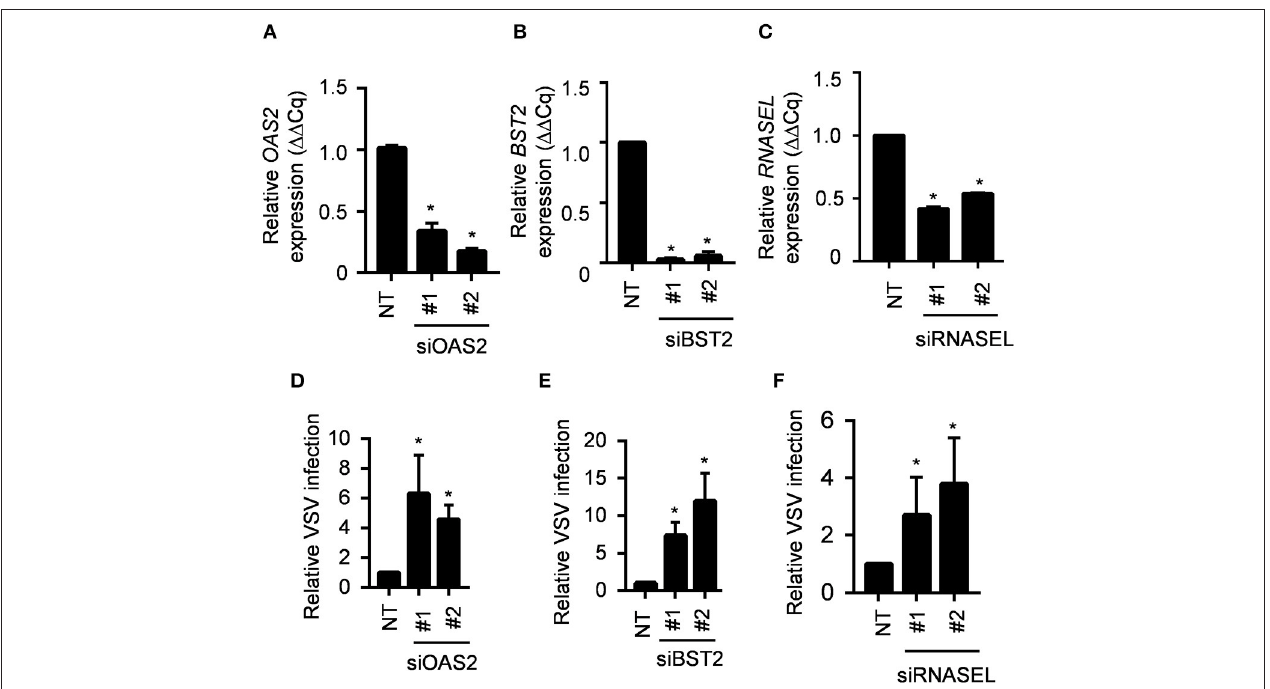
FIGURE 6 | IRF1 dependent genes OAS2, BST2 and RNASEL regulate VSV infection. (A–C) Parent BEAS-2B cells were transfected with siRNAs for OAS2 , BST2, or RNASEL and gene expression was analyzed by RT-qPCR using comparative C q method (2 − 11 Cq ). Data represent mean ± SD from three independent experiments. (D–F) Parent BEAS2B cells were transfected with siRNAs for OAS2 , BST2, or RNASEL and 72h later were infected with VSV (MOI = 0.01). Cells were harvested at 20 hpi for analysis of GFP expression by flow cytometry. Data shown are relative to control siRNA transfected BEAS-2B cells and represent mean ± SD from three independent experiments. *Statistically